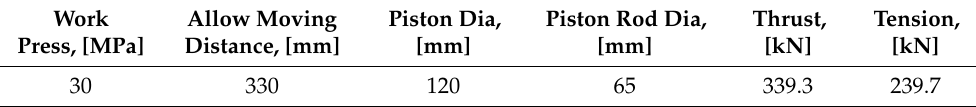
Table 4. Structural and Technical Parameters of Clamping Hydraulic Cylinder.